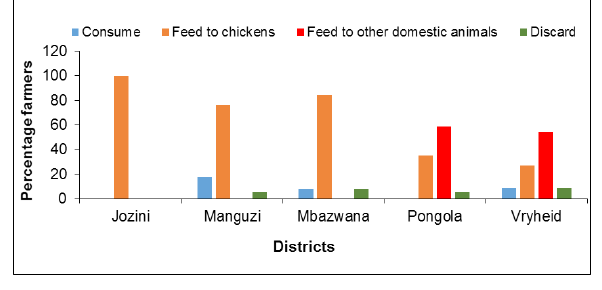
Figure 5: End result of damaged and mouldy maize produced by subsistence farmers in five districts of northern KwaZulu-Natal (chi-square: d.f.=12; p =0.0009).